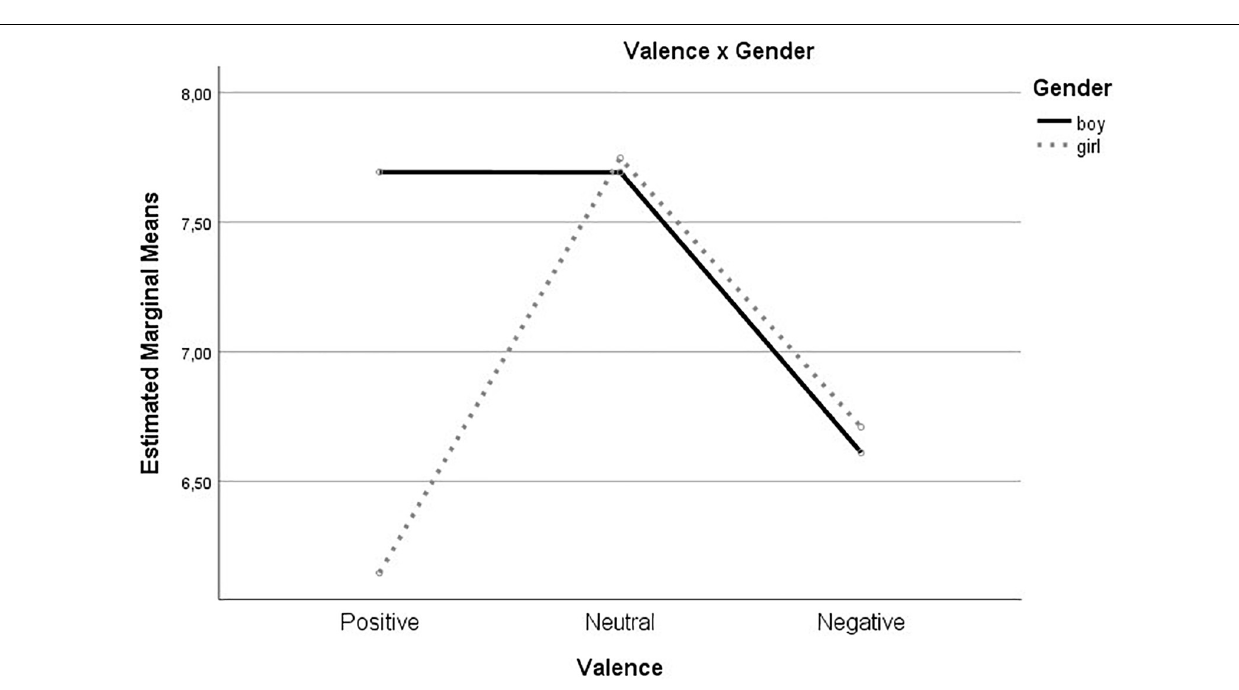
assumed to be associated with a narrowed attentional scope